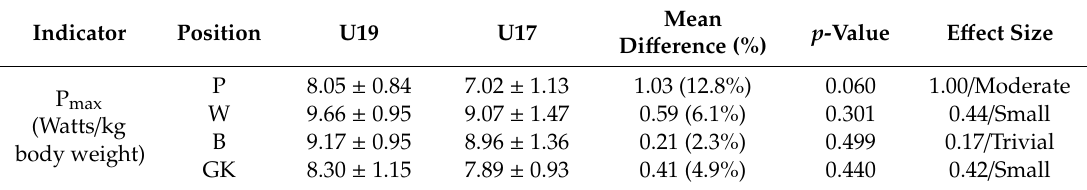
Table 3. Power output (watts / kg body weight) and fatigue index (FI) in handball players as determined by the running-based anaerobic sprint test